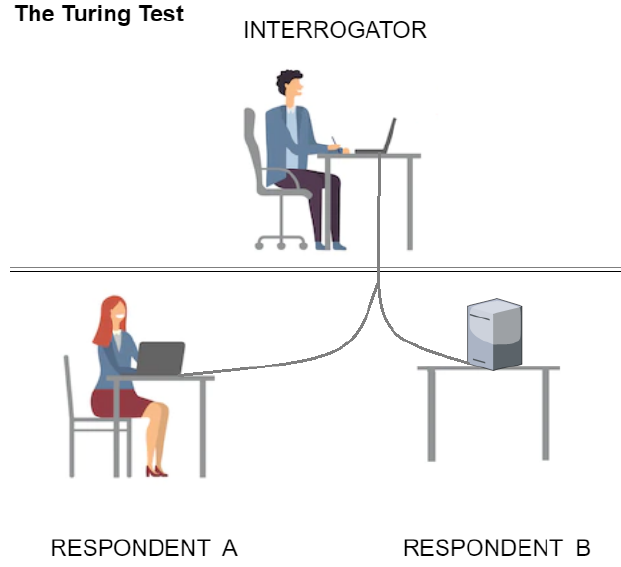
Figure 1. Turing Figure 1. Turing test.